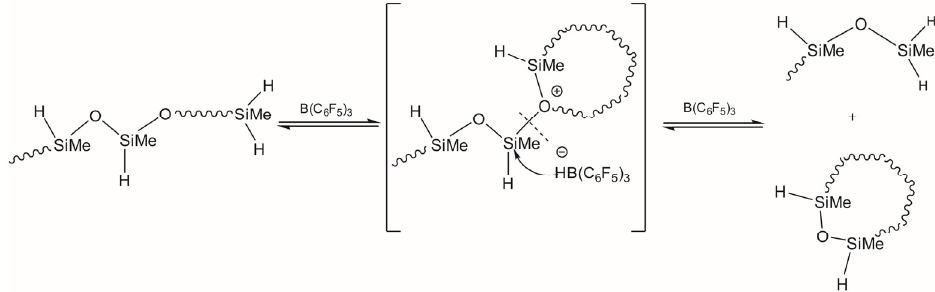
Scheme 3. Formation of cyclic oligomers, D Hx , during the restructuring of PHMS.